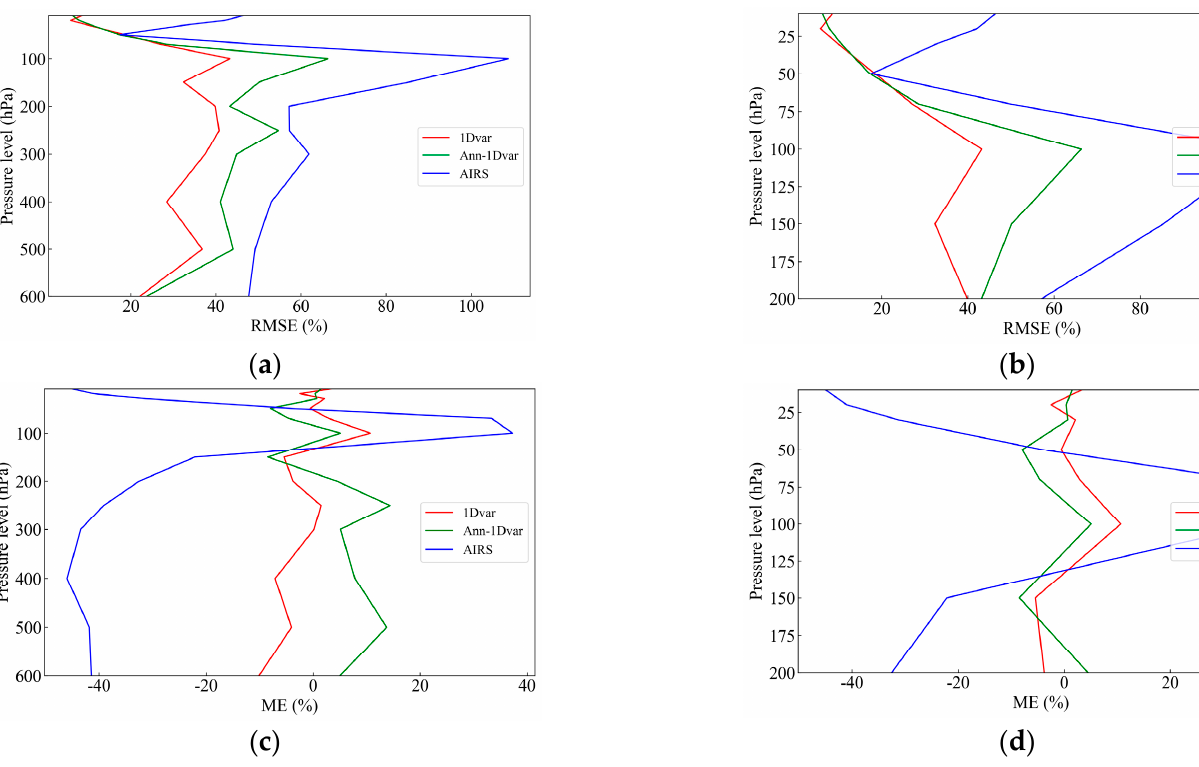
Figure 10. A comparison between the retrieved profile and AIRS product profile, where the true values are taken from ERA5 data: ( a ) 10–600 hPa RMSE (%), ( b ) 10–200 hPa RMSE (%), ( c ) 10–600 hPa ME (%), ( d ) 10–200 hPa ME (%). The red line, 1Dvar, is the traditional 1D − VAR physical retrieval algorithm retrieval ozone profile result obtained with GFS data as the initial profile. The green line, Ann_1Dvar, is the retrieval result obtained by adding the neural network method to optimize the initial profile combined with the traditional 1D − VAR physical retrieval algorithm. The blue line, AIRS, is the ozone profile of AIRS L2 Ozone product.